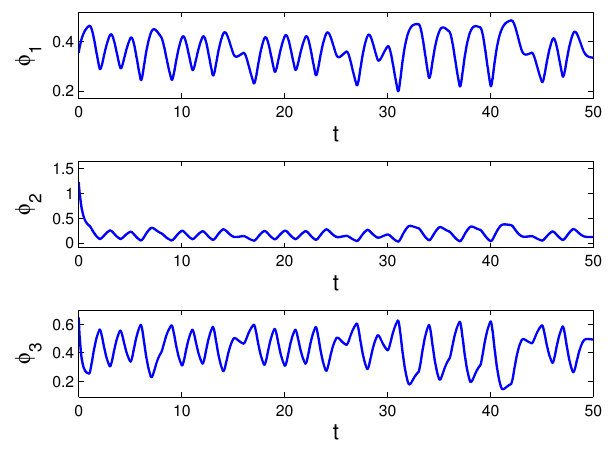
Figure 2. The time series of the coordinates φ 1 , φ 2 and φ 3 of the solution of system (16) with the initial conditions φ 1 ( 0 ) = 0.355, φ 2 ( 0 ) = 1.235, φ 3 ( 0 ) =